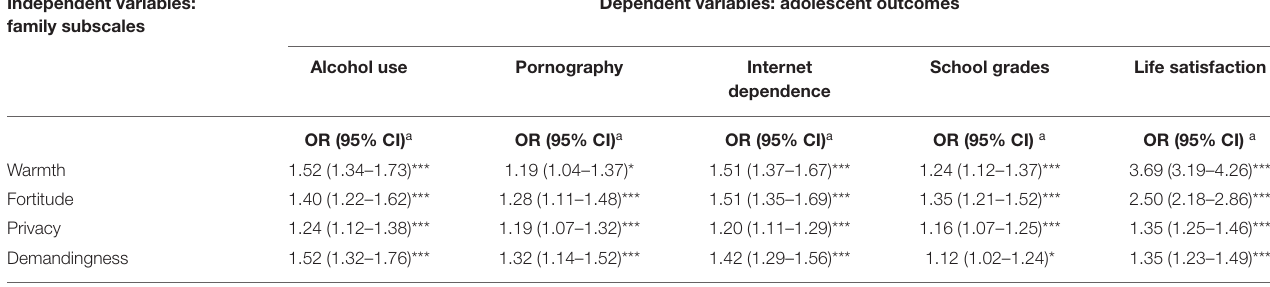
TABLE 6 | Association between parenting dimensions and adolescent outcomes. Independent variables: family